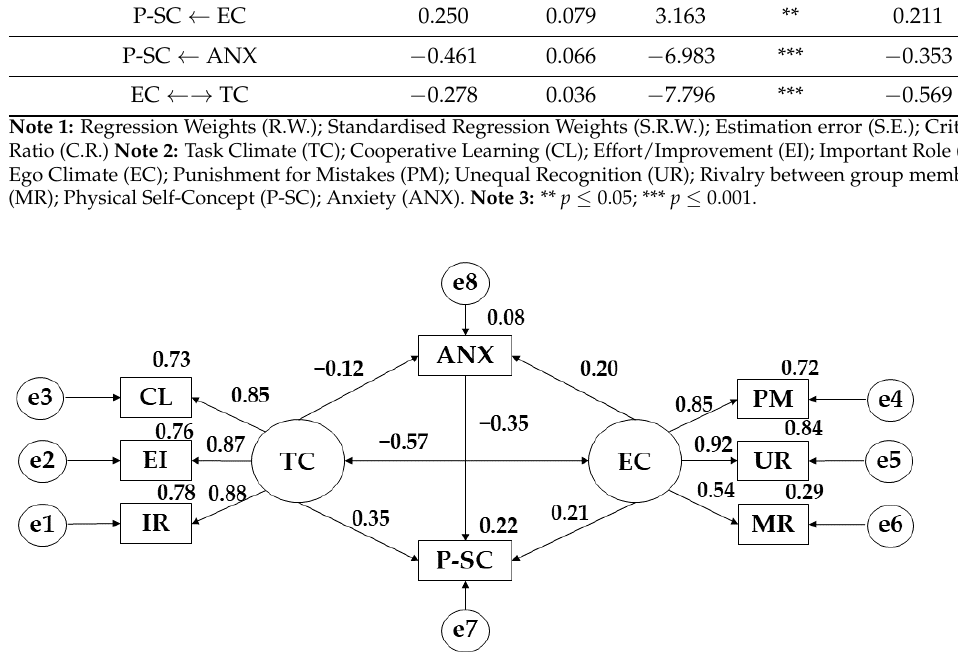
Figure 2. Model developed for low adherence to the Mediterranean Diet. Note: Task Climate (TC); Cooperative Learning (CL); Effort/Improvement (EI); Important Role (IR); Ego Climate (EC); Punishment for Mistakes (PM); Unequal Recognition (UR); Member Rivalry (MR); Physical Self-Concept (P-SC); Anxiety (ANX).